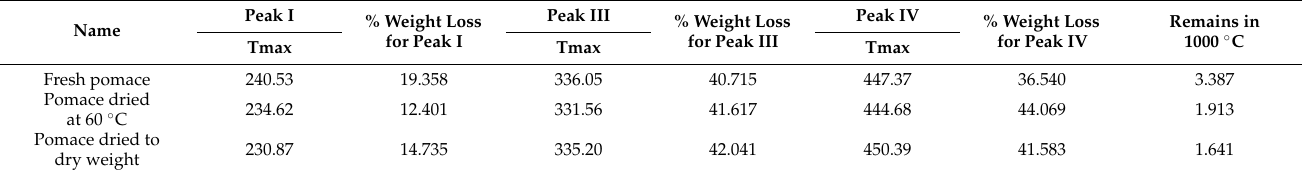
Figure 9. TGA curves for fresh apple pomace. Analysis in an oxygen atmosphere (black line is a curve of mass loss versus temperature, green line is the first derivative). curve of mass loss versus temperature, green line is the first derivative). Table 5. Percent weight loss and peak maximum temperature (°C) for apple-pomace samples based Table 5. Percent weight loss and peak maximum temperature ( ◦ C) for apple-pomace samples based on the obtained TGA curves. Analysis in an oxygen atmosphere. on the obtained TGA curves. Analysis in an oxygen